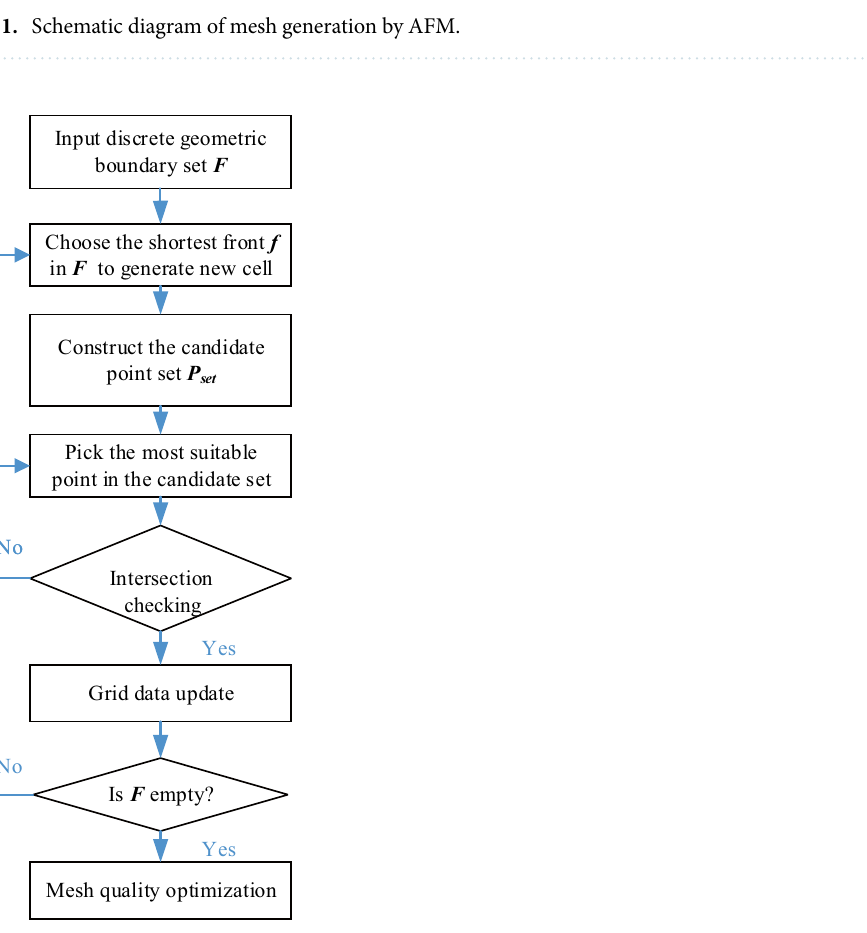
Figure 2. Flowchart for triangular mesh generation by the traditional